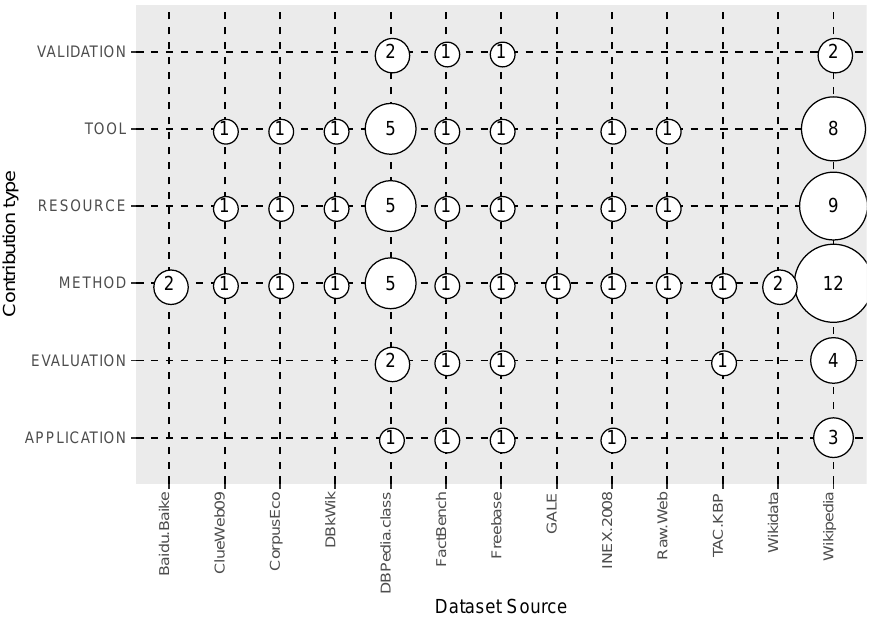
Figure 13. Map of Dataset Sources and types of contribution identified—for the x -axis, the Dataset Sources bases; for the y -axis, the type of contributions. (Authors’ own).